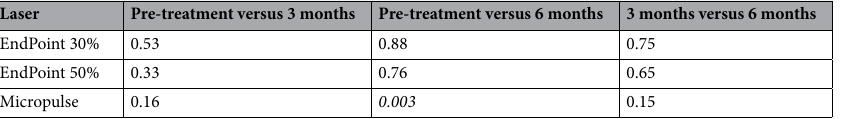
Table 2. Adjusted p-values for comparisons of best-corrected visual acuity in eyes with diabetic macular edema at different time points among three treatment groups. Statistically significant value is in italics